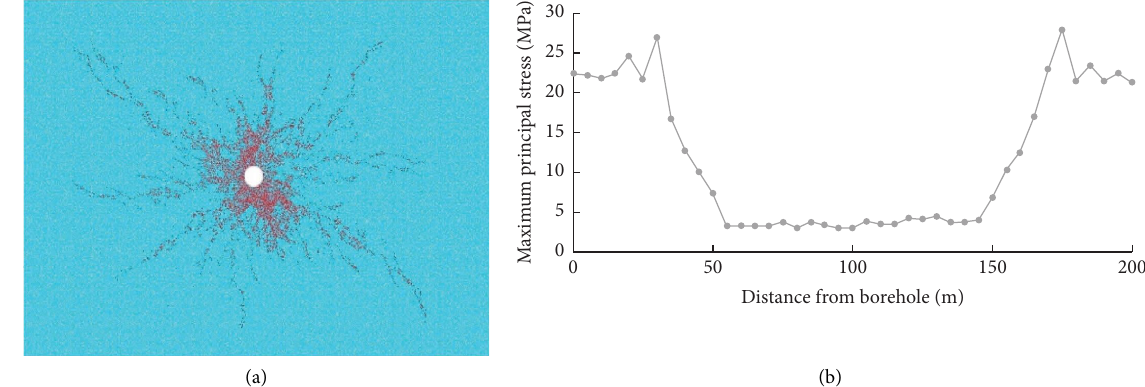
Figure 7: Fracture and stress distribution when fracturing pressure is 25 MPa. (a) Distribution of fractures. (b) Stress distribution